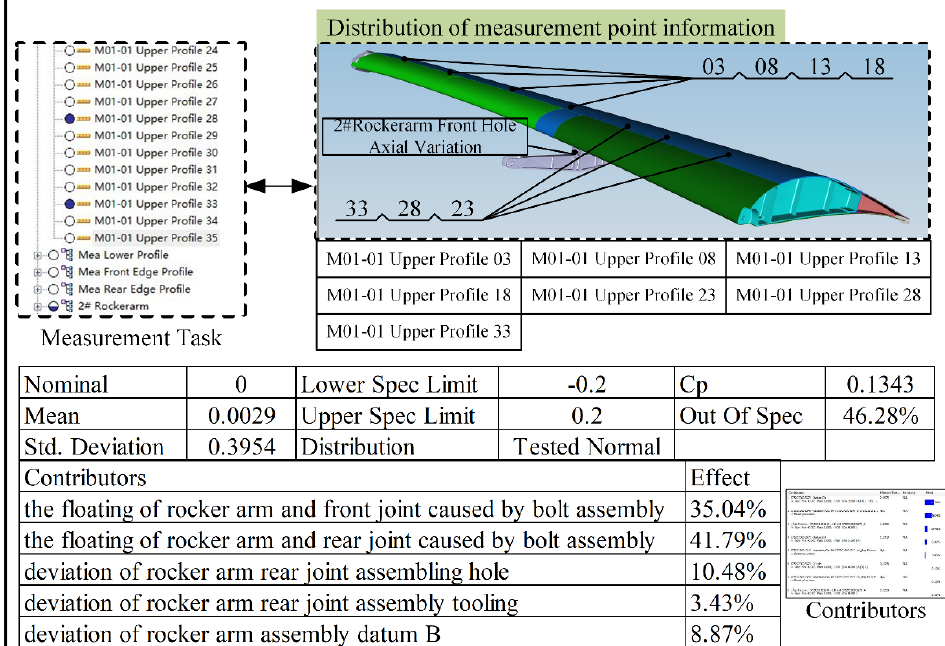
Figure 8. Assembly precision analysis result of inner flap.